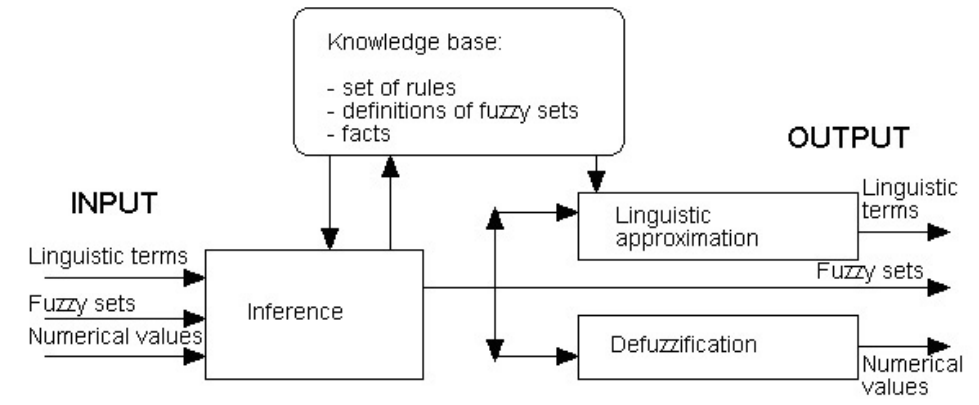
FIGURE 6. Information flow in the fuzzy knowledge–based